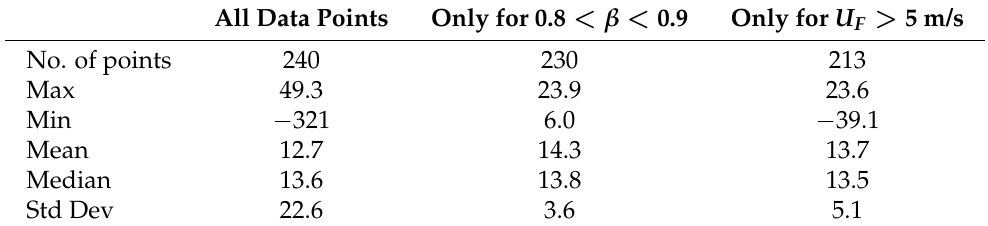
Table 3. Comparison of the three data sets of ζ plotted in Figure